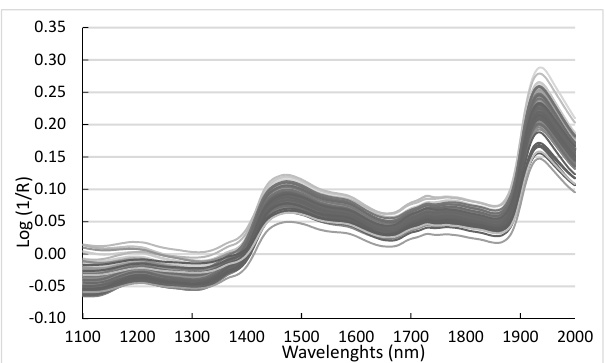
Figure 3. Spectra from NIR range (1100–2000 nm) of the 216 samples of endophyte-infected Schedonorus pratensis.